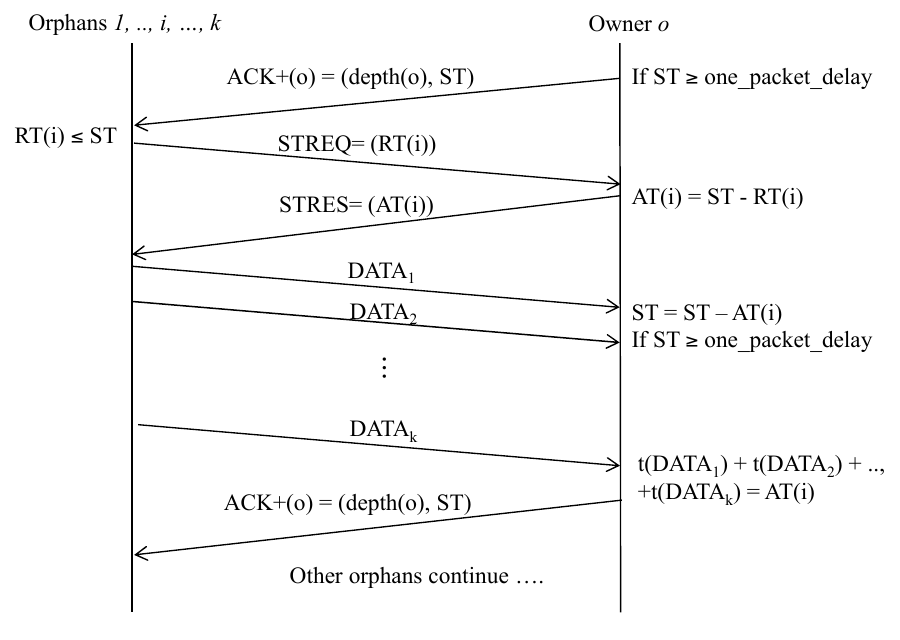
Figure 7. Spare time utilization process.